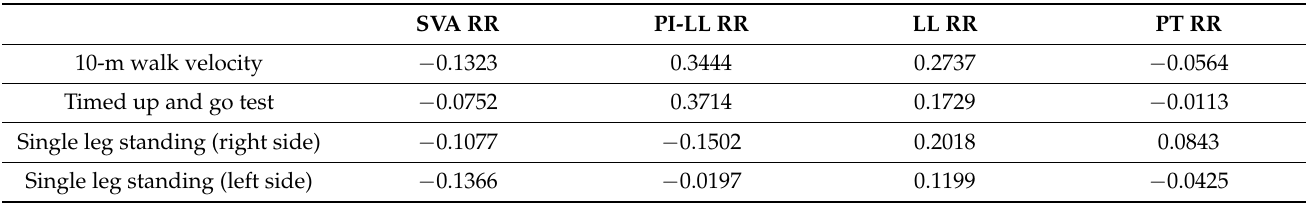
Table 4. Correlation between spinopelvic parameters and gait ability and spinal balance. SVA RR PI-LL